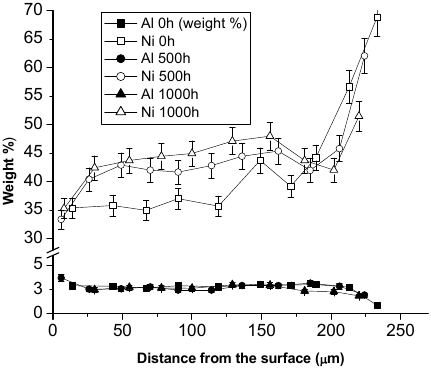
Figure 8. Ni and Al concentration profile for HVOF sprayed CoNiCrAlY on IN738 at 0, 500 and 1000 h of isothermal test.